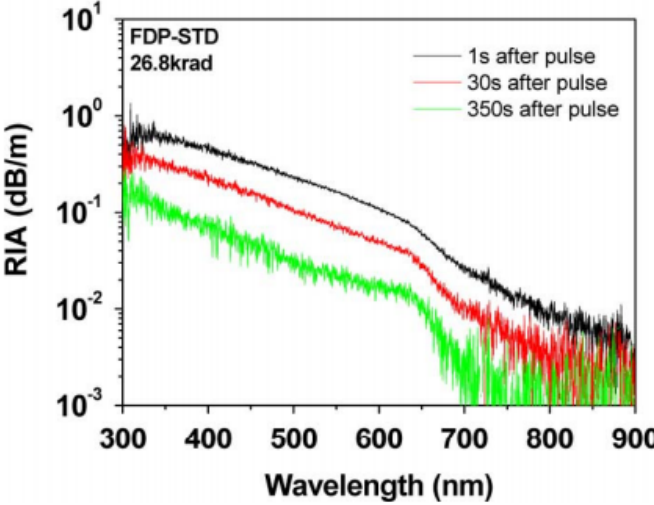
Figure 11. Spectral radiation dependance of the RIA at 3 different times of a solarization-resistant optical fiber from POLYMICRO, the FDP-STD fiber